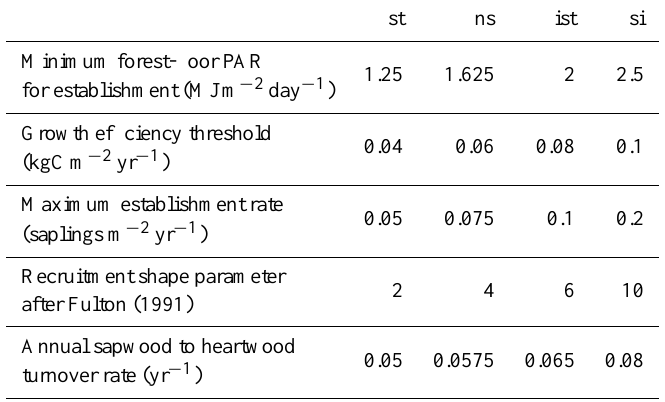
Table D1. Shade tolerance parameters. The affiliations to species are given in Table D3. st: shade-tolerant; ns: nearly shade-tolerant; ist: intermediate shade-tolerant; si: shade-intolerant.